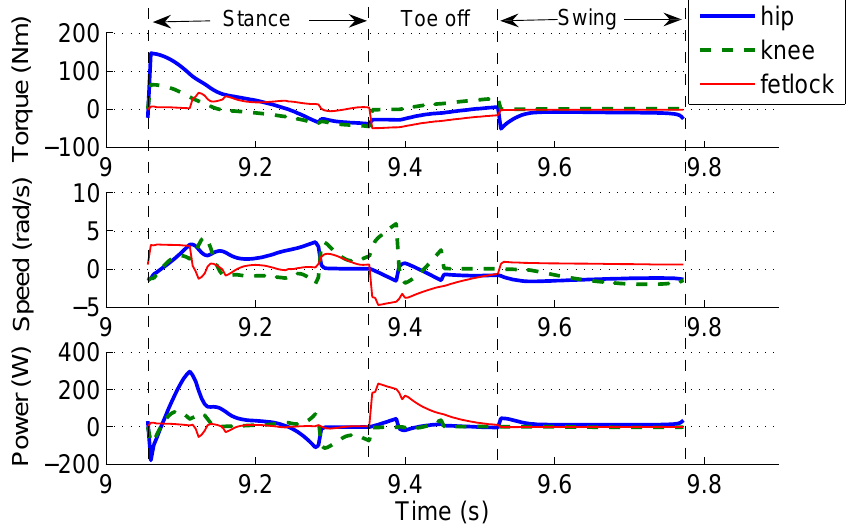
Stance Toe off Swing Figure 6. Requirements of torque, speed and power for the joints of a lightweight HADE leg running at 1.5 m/s carrying a 12 kg load in a locomotion